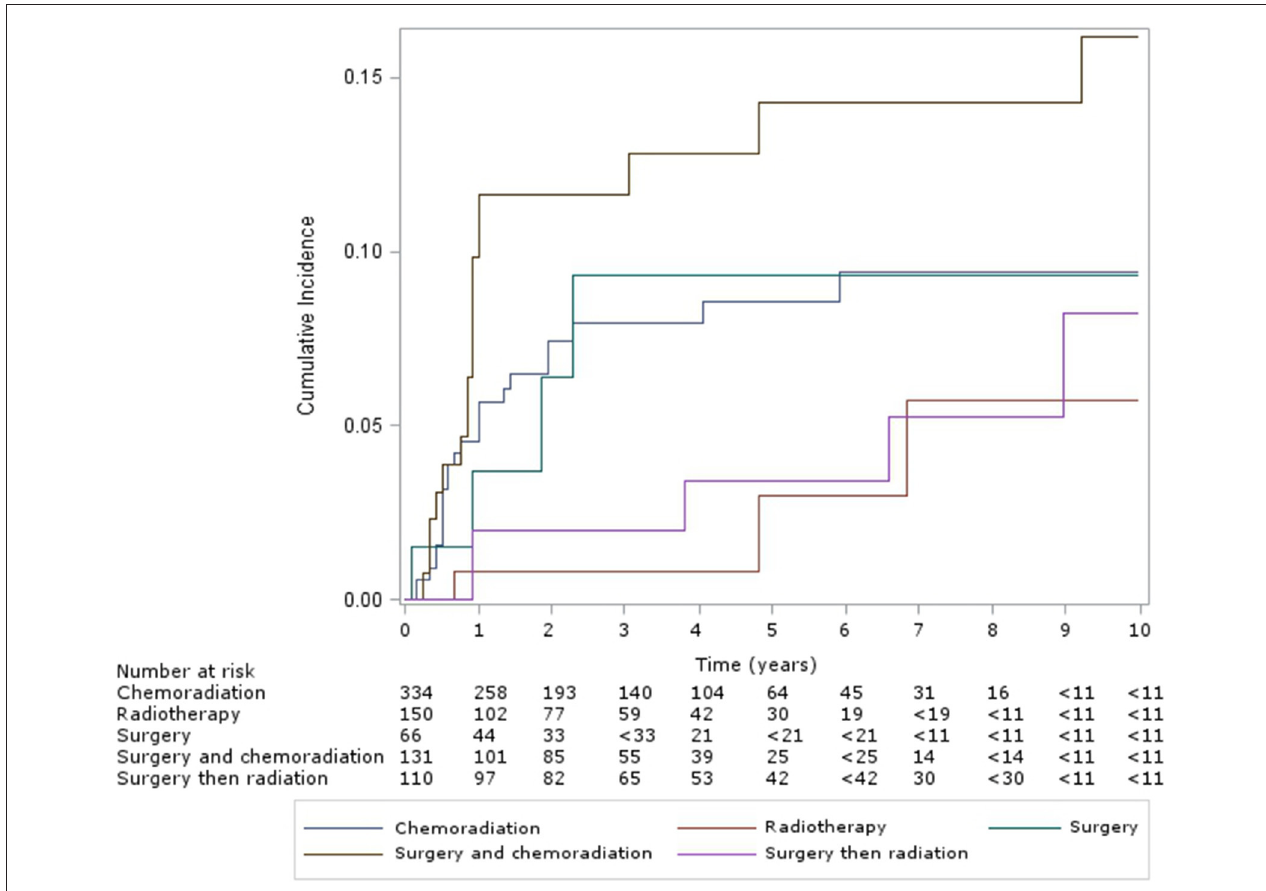
FIGURE 3 | Cumulative incidence of esophageal dilation in oropharynx patients, by treatment